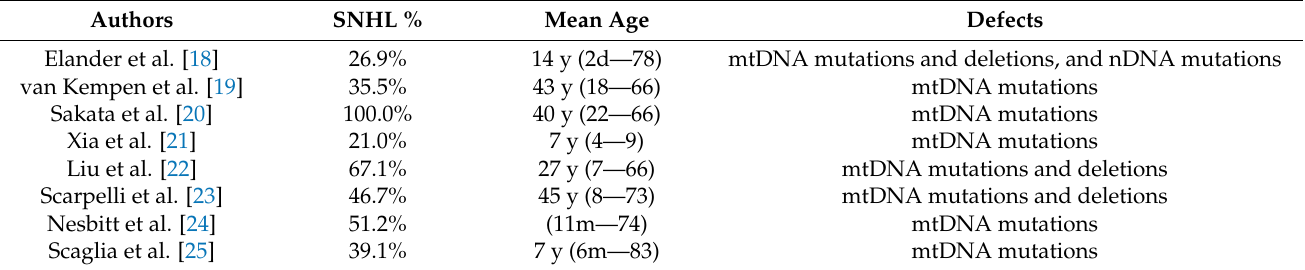
Table 2. Prevalence (%) of sensorineural hearing loss (SNHL) in the different cohorts of patients (d: days; m: months; and y: years).